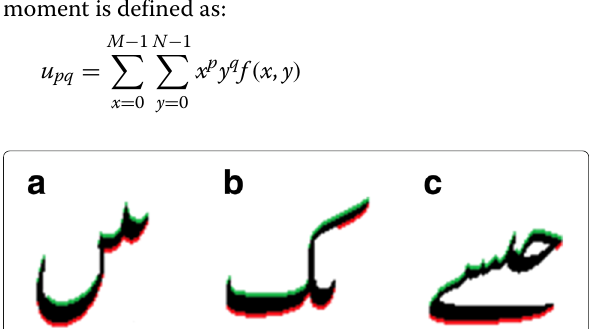
Fig. 13 Primary ligatures with upper (green) and lower (red) profiles as reference